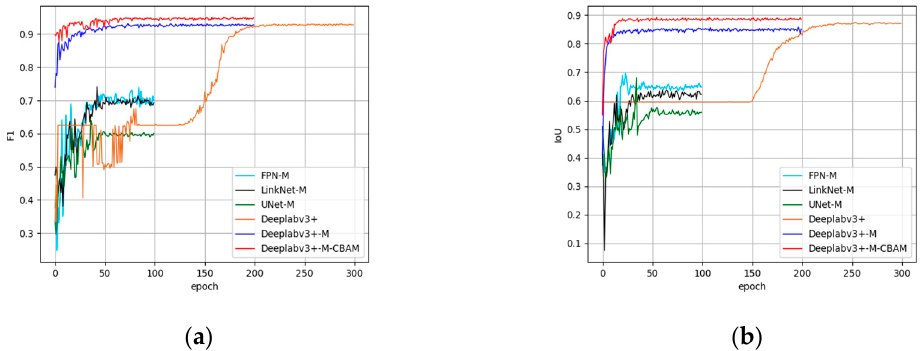
Figure 12. Accuracy curves of the 6 models: ( a ) F1 curves on the validation set; ( b ) IoU curves on the validation set.